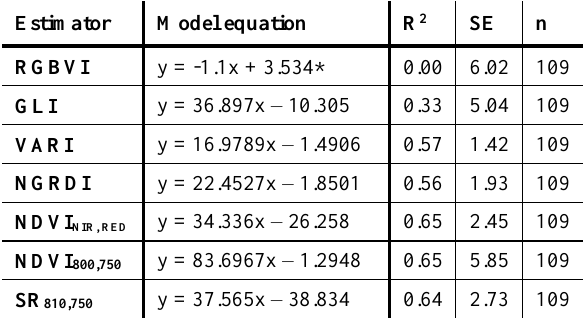
Table 2. Regression models of the calibration dataset. * P > 0.5, all other P < 0.005